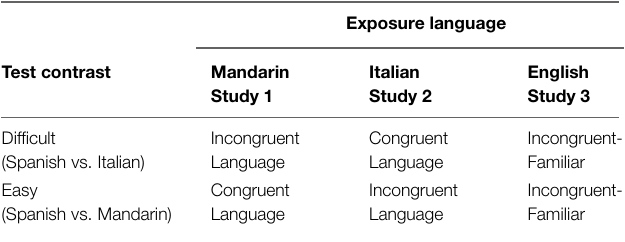
TABLE 2 | Congruency of exposure language and test